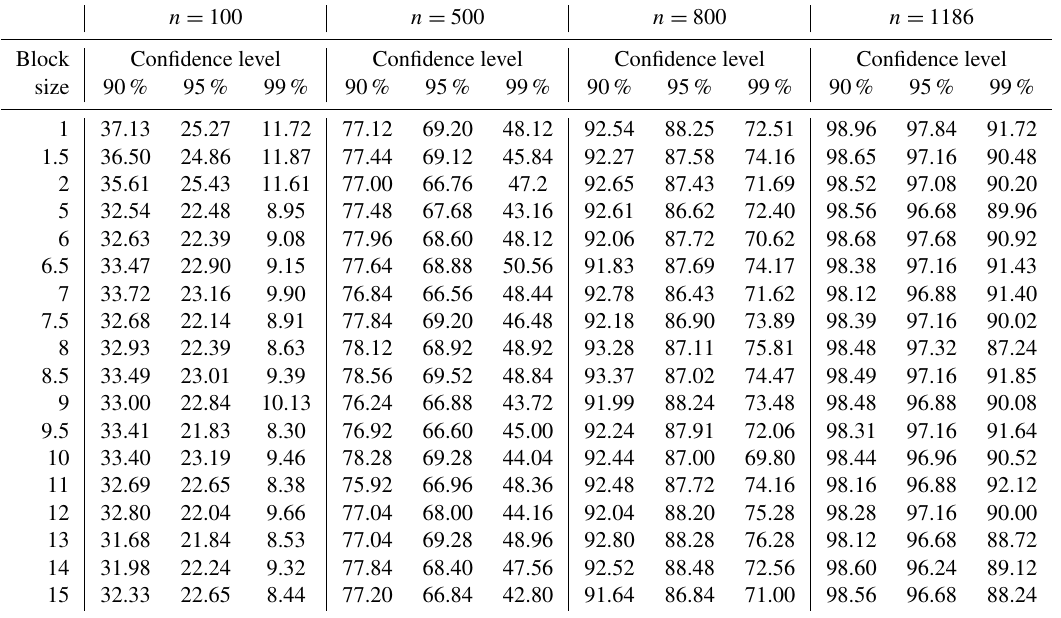
Table 2. The power of the homogeneity test (%). Null hypothesis: the VAR(1) process of Budapest and Apatovac for different block sizes and sample sizes ( n ). Alternative hypothesis: also a VAR(1) process, but with other parameters, representing stronger dependence. n = 100 n = 500 n = 800 Block Confidence level Confidence level Confidence level Confidence level